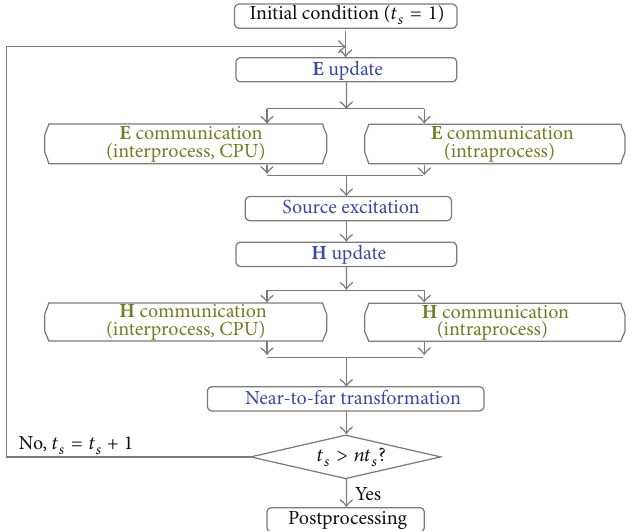
Figure1:TheflowchartofcudaFDTD.Themoduleswritteninbluemeanthemaincalculationsandthatinbrownmeandatacommunications. Note that the interprocess is done by only CPU; other function modules are treated by CPU and GPU